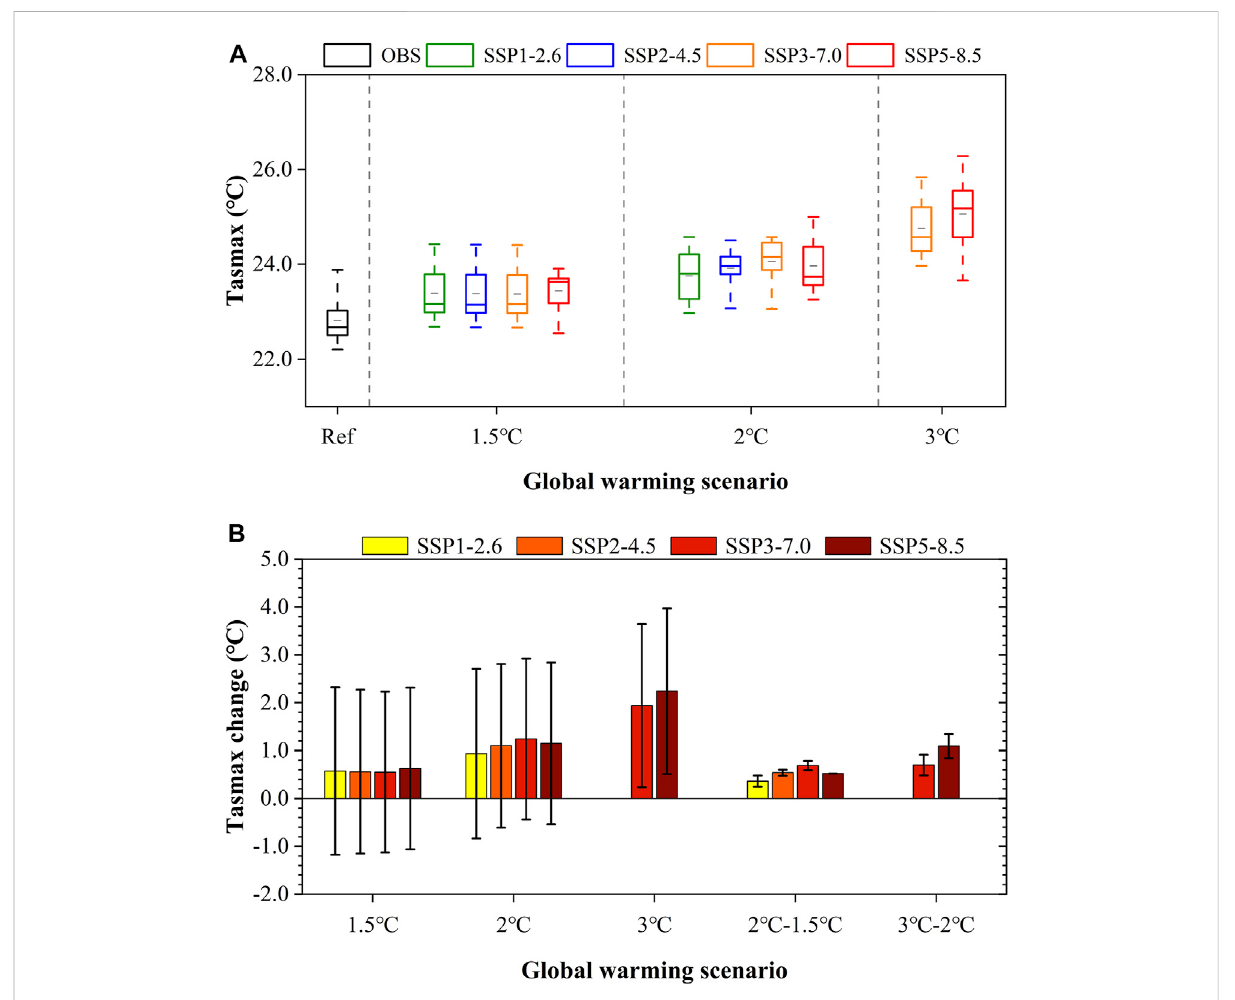
FIGURE 9 Boxplot diagram of Tasmax change under different scenarios (A) and the error bar plot of Tasmax change relative to the reference period (B) in the